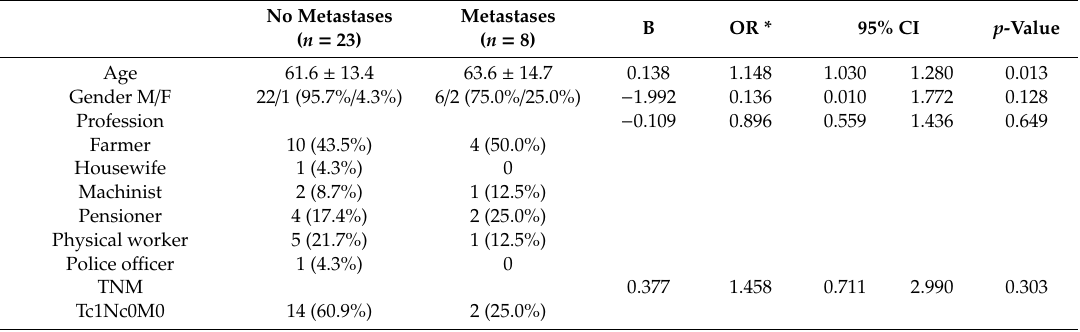
Table 5. The predictive values for risk factor with calculated odds ratios (OR) with a 95% confidential interval (CI) for neck metastases.